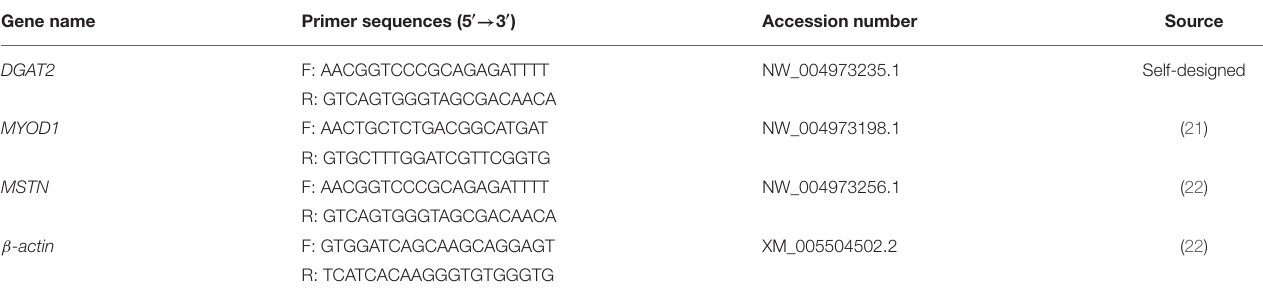
TABLE 1 | Primer sequences for quantitative real-time PCR